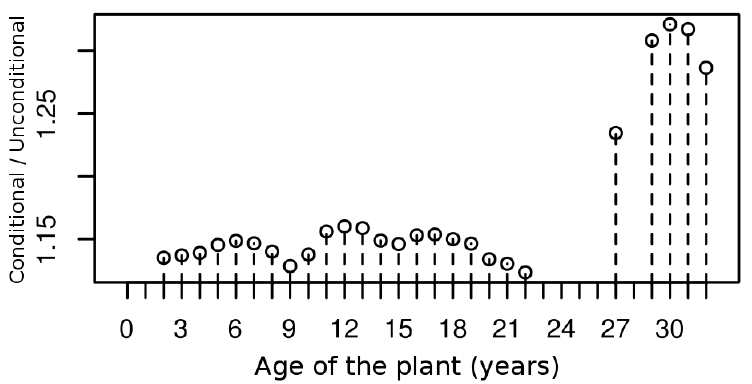
Figure 5. Partial regression plot of Age